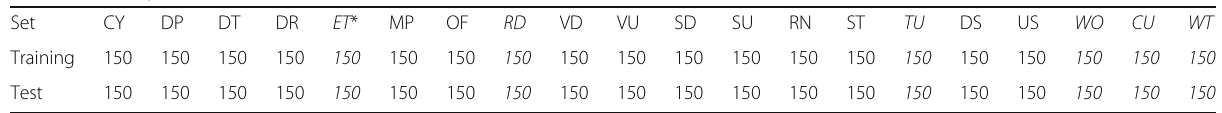
Table 10 Composition of the converted dataset M -20